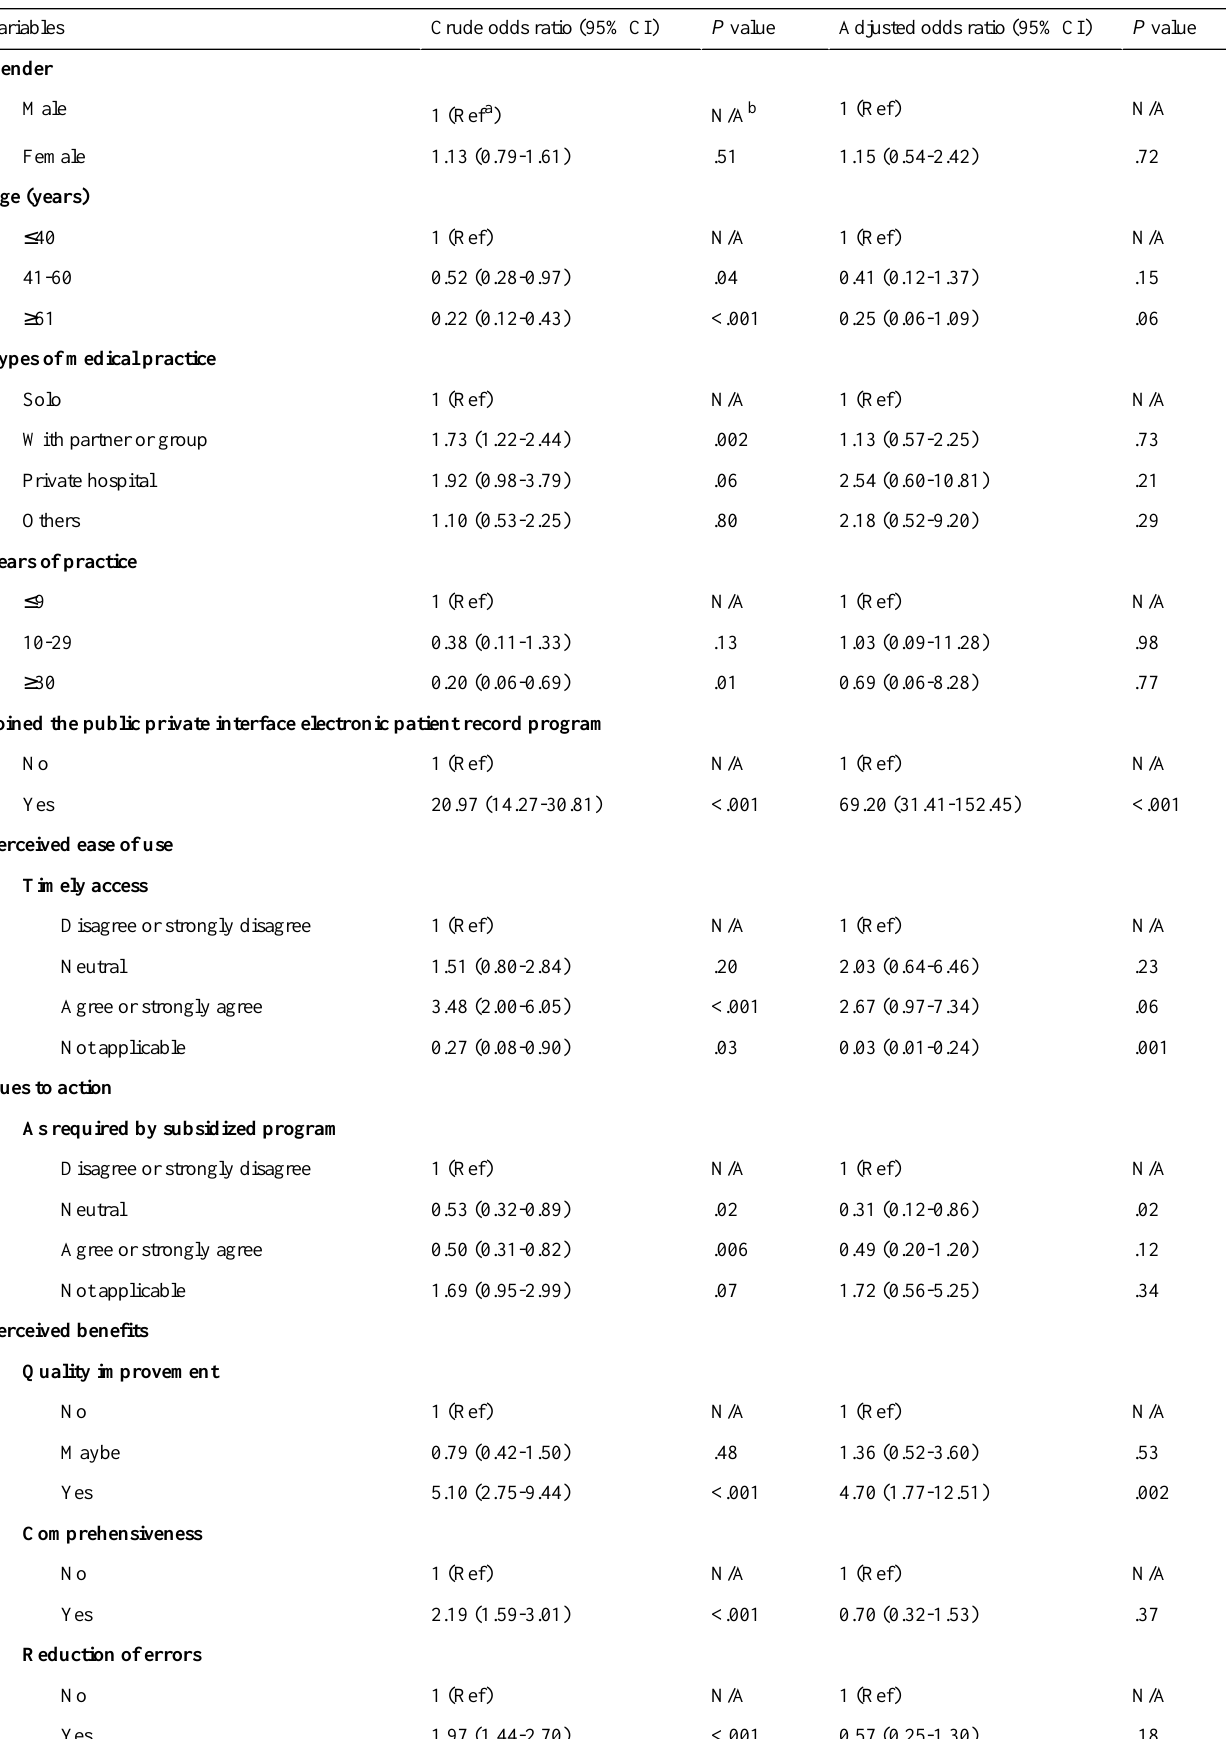
Table 4. Factors associated with the status of registration among